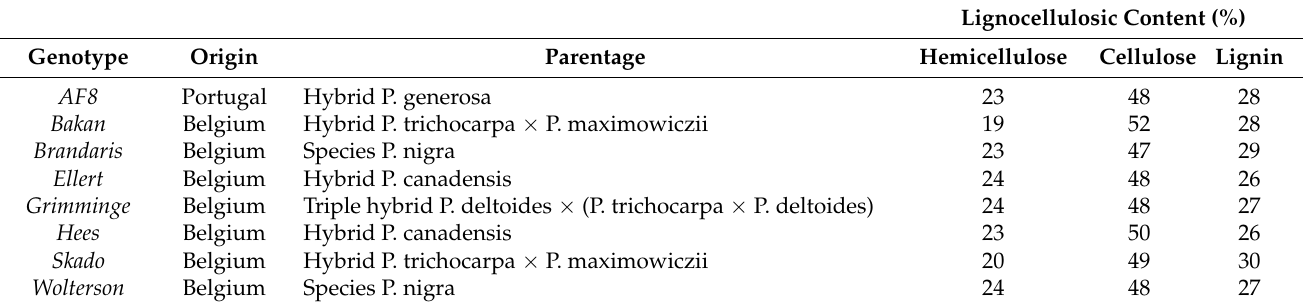
Lignocellulosic Content